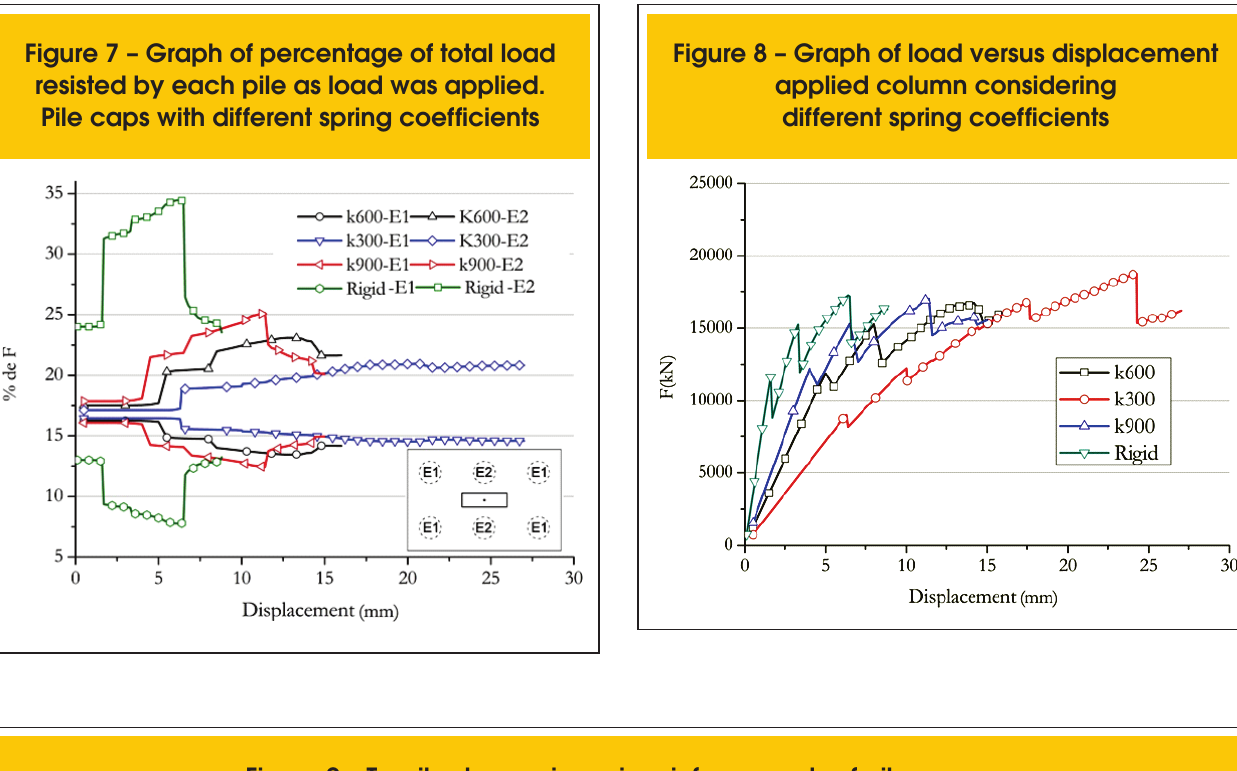
Figure 9 – Tensile stresses in main reinforcements of pile